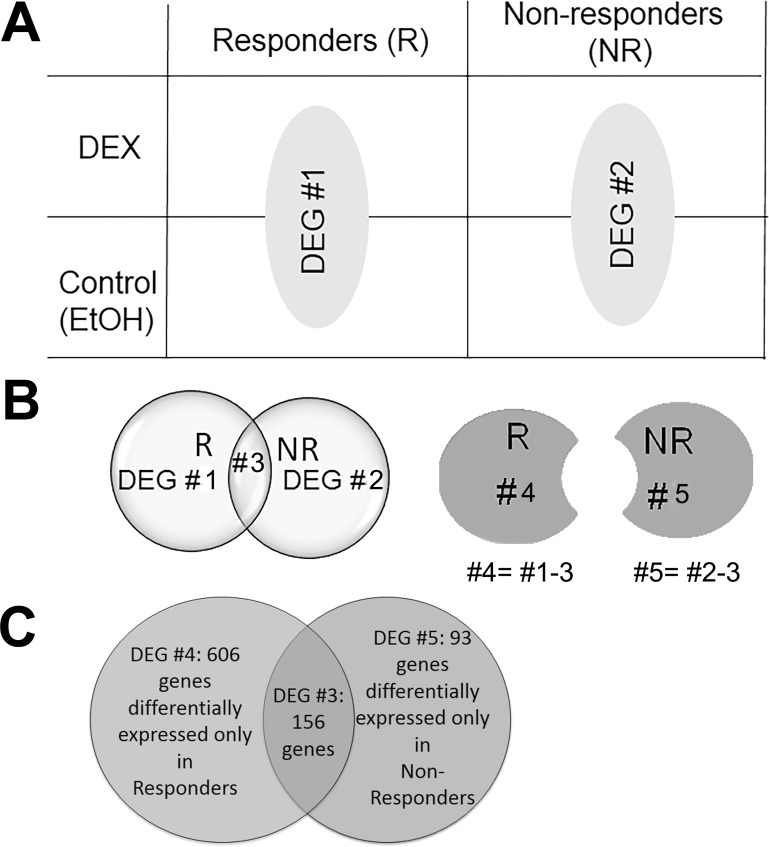
Diagram of differential expression groupings (DEG).The four groups of raw data (responders and non-responder BTM cells treated with DEX or EtOH) were grouped into 5 DEGs. A) The initial grouping of raw data. DEG #1: DEX vs. EtOH in responders; DEG #2: DEX vs. EtOH in non-responders. B) Further grouping of DEGs 3–5. DEG #3: overlap between DEG groups #1 and 2; DEG #4 = 1–3; DEG #5 = 2–3. C) The number of genes in DEGs#3, 4, and 5.